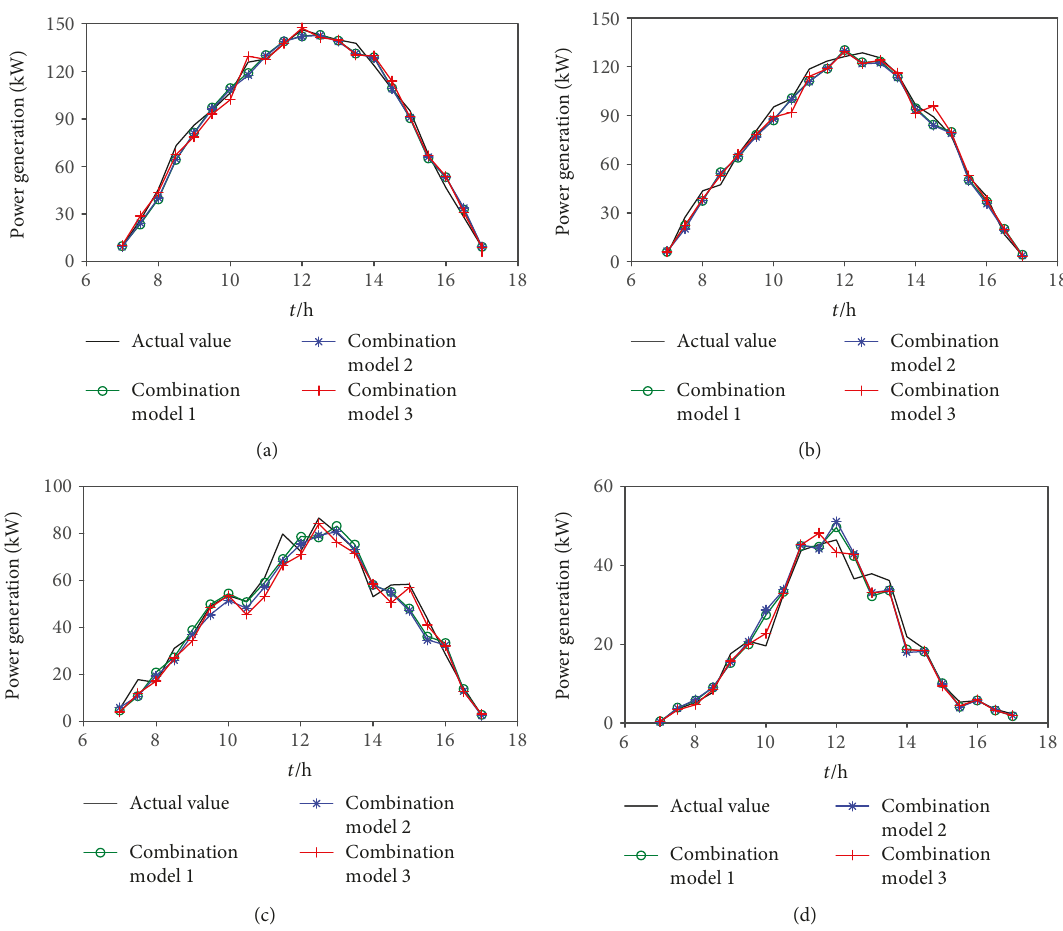
Figure 4: Forecasting results of combination forecasting models. (a) Sunny day. (b) Cloudy day. (c) Overcast day. (d) Rainy